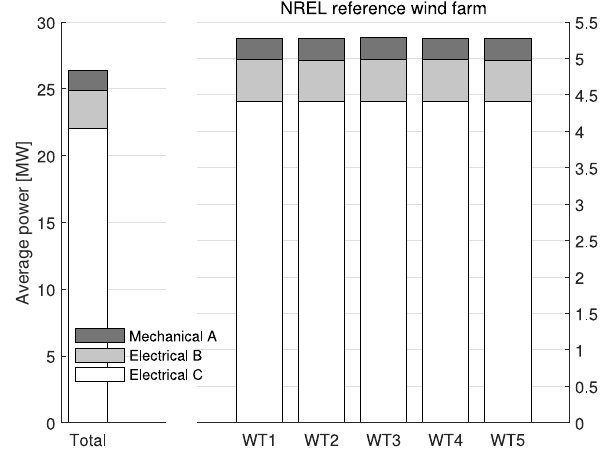
Figure 16. Power performance for the reference wind farm, above rated conditions.